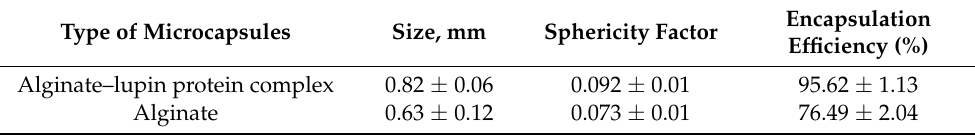
Encapsulation Efficiency (%)